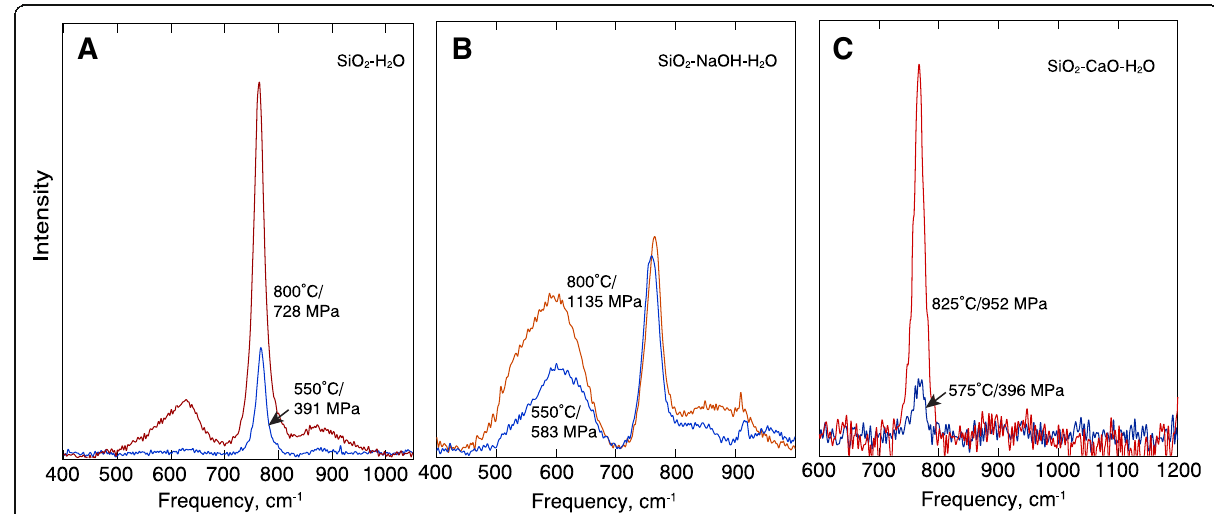
Fig. 4 Examples of low-frequency portion of Raman spectra in the systems SiO 2 – H 2 O ( a ), SiO 2 – NaOH – H 2 O ( b ), and SiO 2 – CaO – H 2 O ( c ) at pressure and temperature conditions as indicated on individual